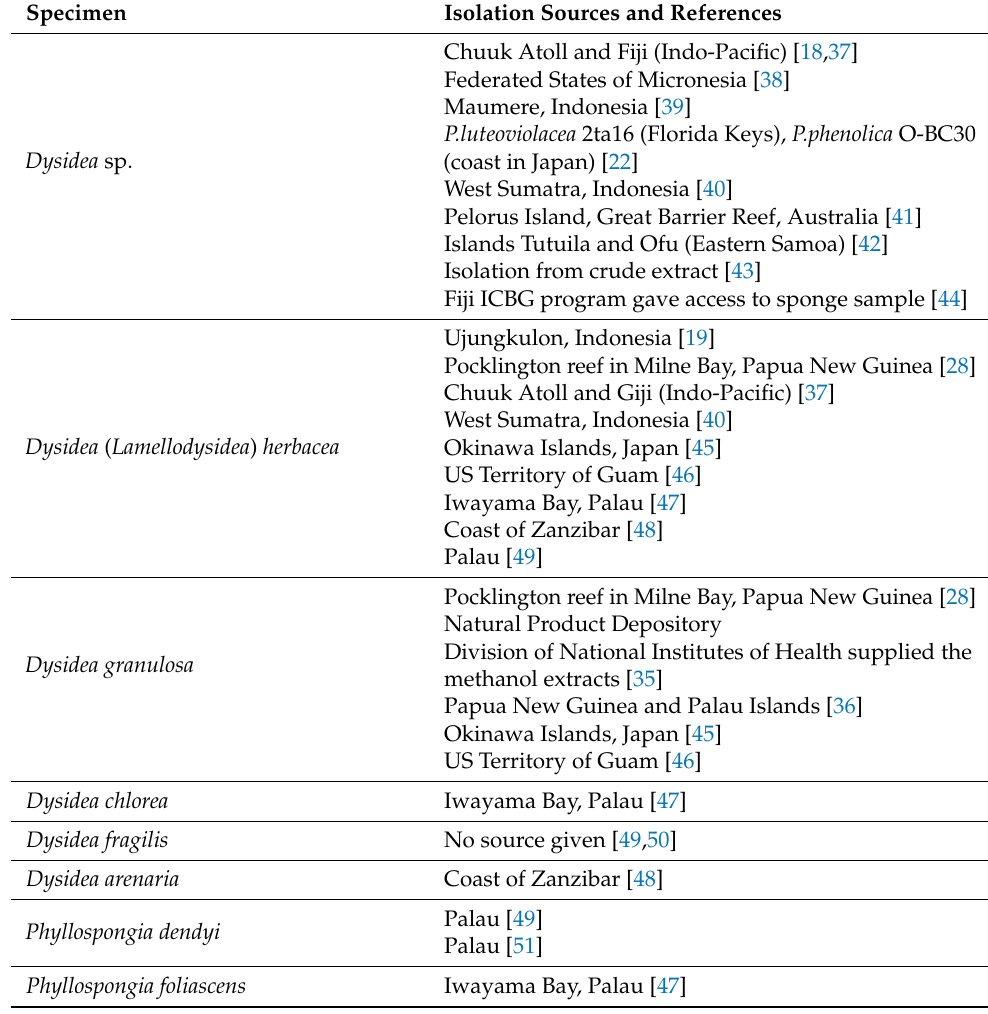
Table 1. List of sponge species associated with the production of PBDEs, corresponding isolation sources, and respective